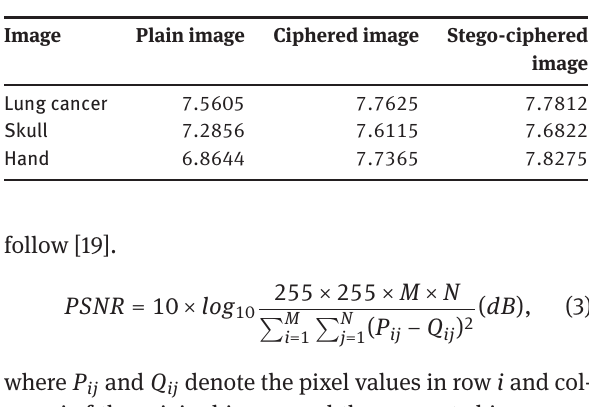
Table 6: Entropy value of: Plain image, Ciphered image and